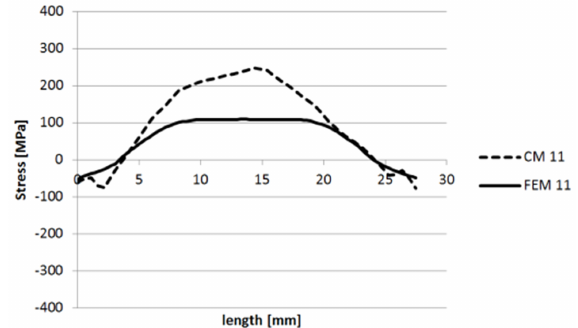
Figure 26. Stress levels in 11 direction along the CD line segment.